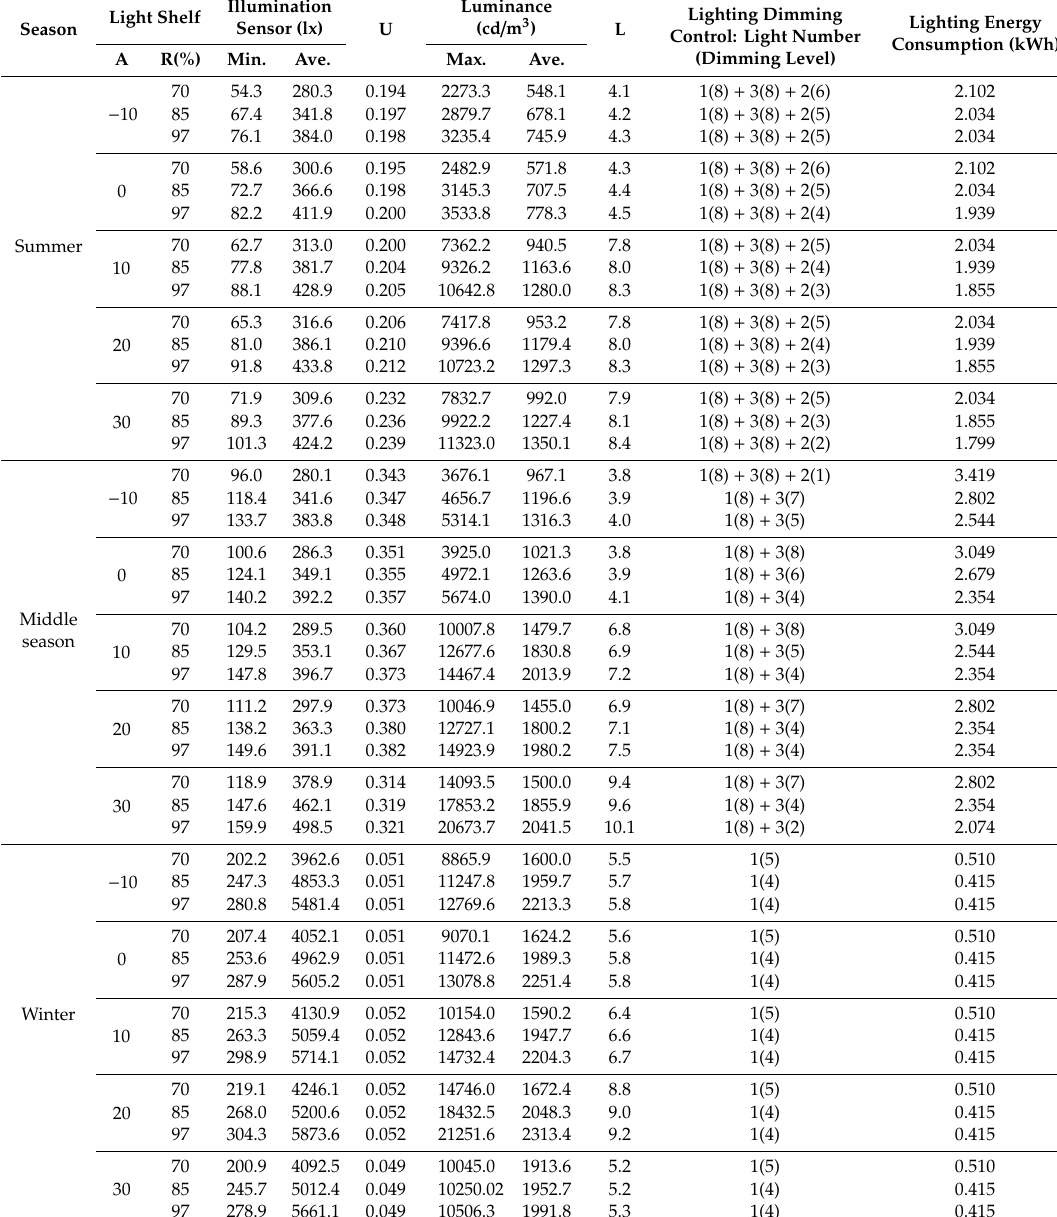
Table 9. Performance evaluation results of Case 3: analysis of uniformity, glare, and lighting energy consumption.